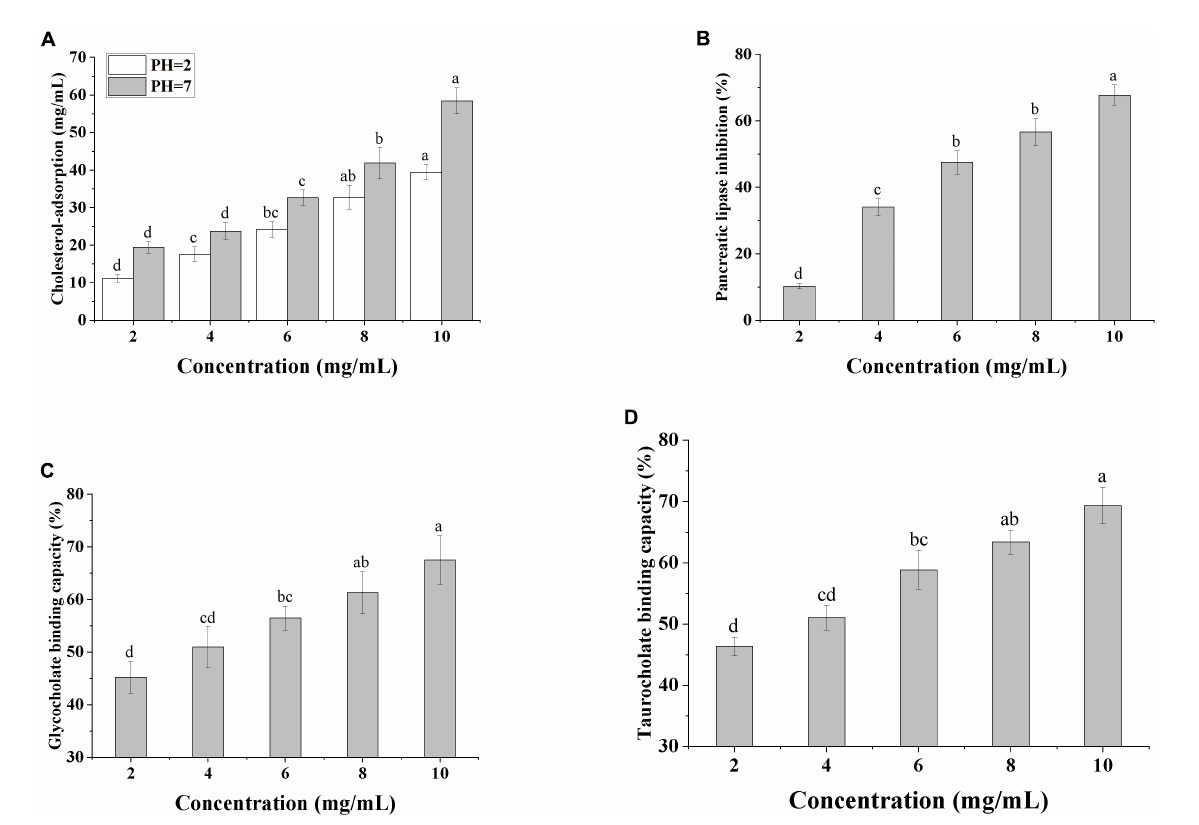
FIGURE9 In vitro determination of the hypolipidemic capacity. (A) Cholesterol-adsorption capacities of SRF-3. (B) Pancreatic Lipase inhibition capacity of SRF-3. (C) Glycocholate binding capacity of SRF-3. (D) Taurocholate binding capacity of SRF-3. Values with different letters (a–d) were significantly different ( p <